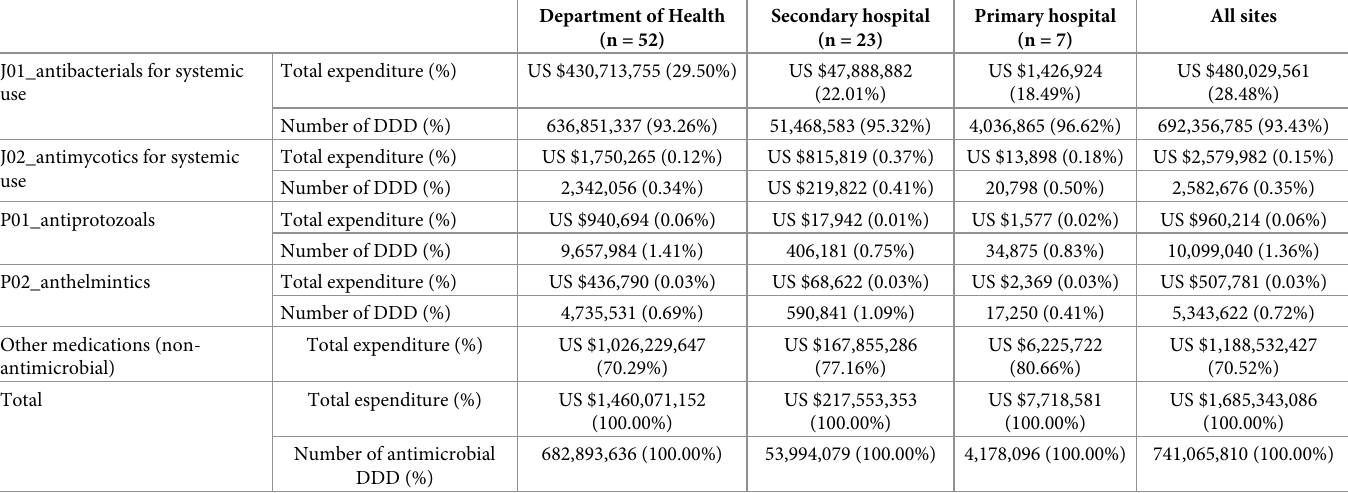
Table 1. Expenditure and number of DDD.